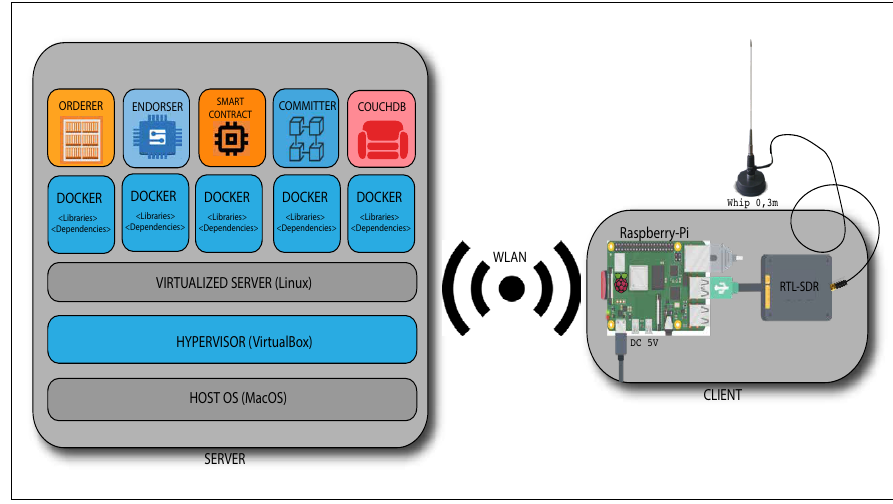
Figure 5. Experiment